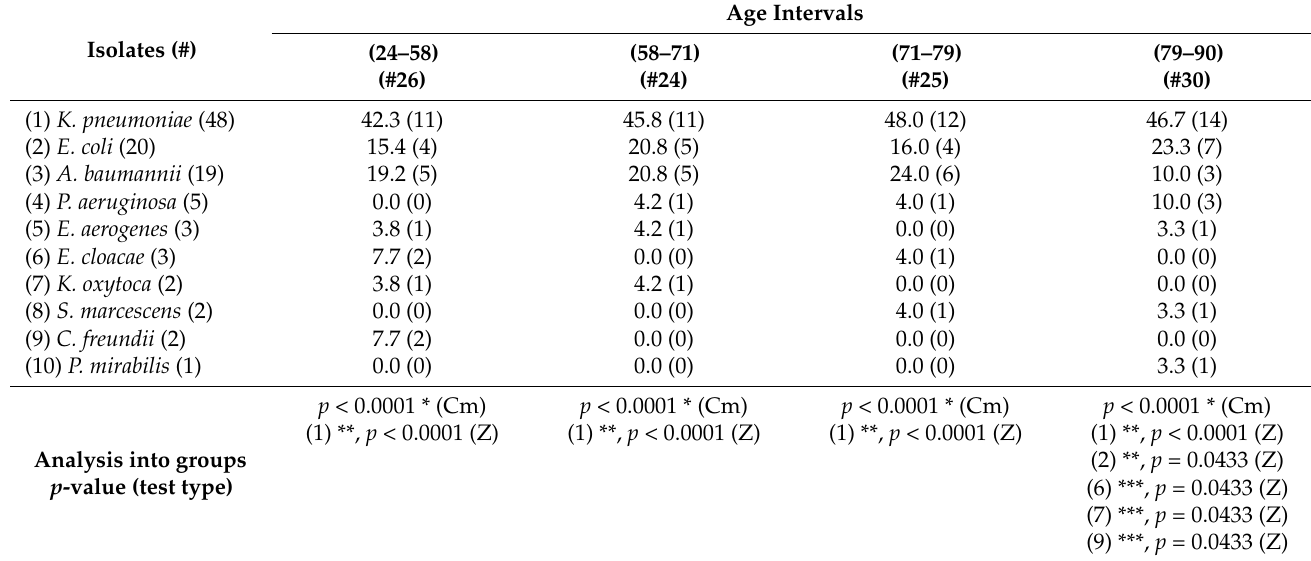
Table 2. Analysis of 105 Gram-negative bacteria (GNB) stratified by class of age.